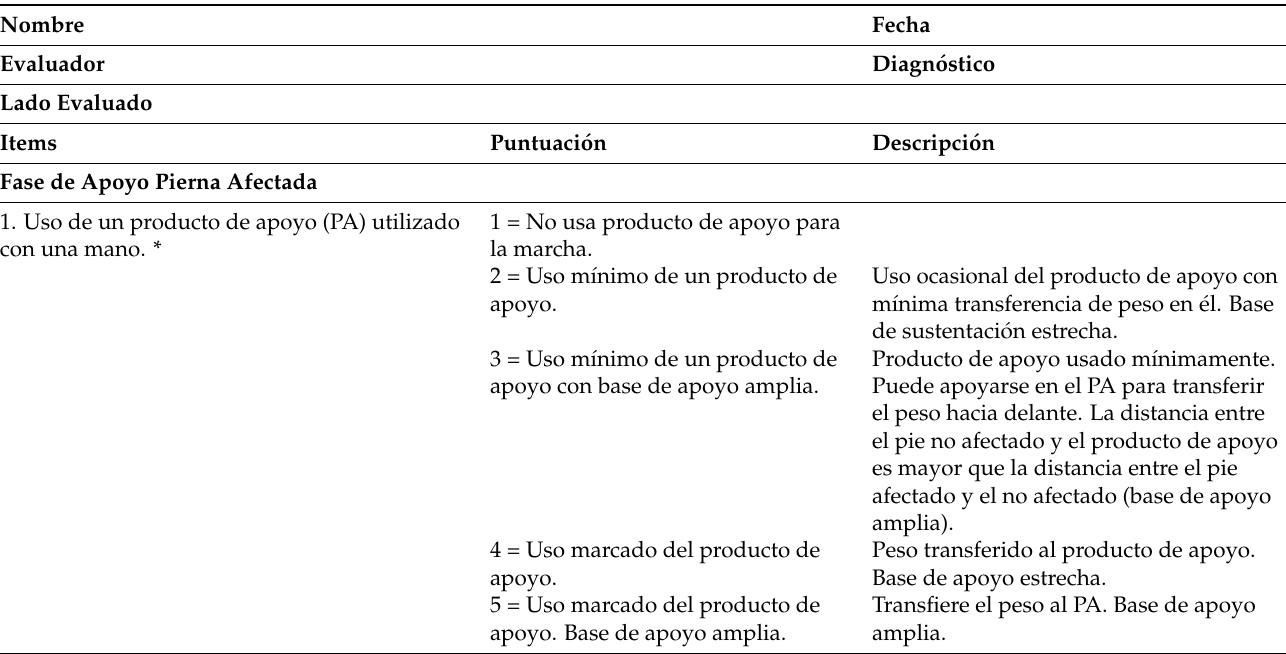
Table 1. Spanish version of the Wisconsin Gait Scale